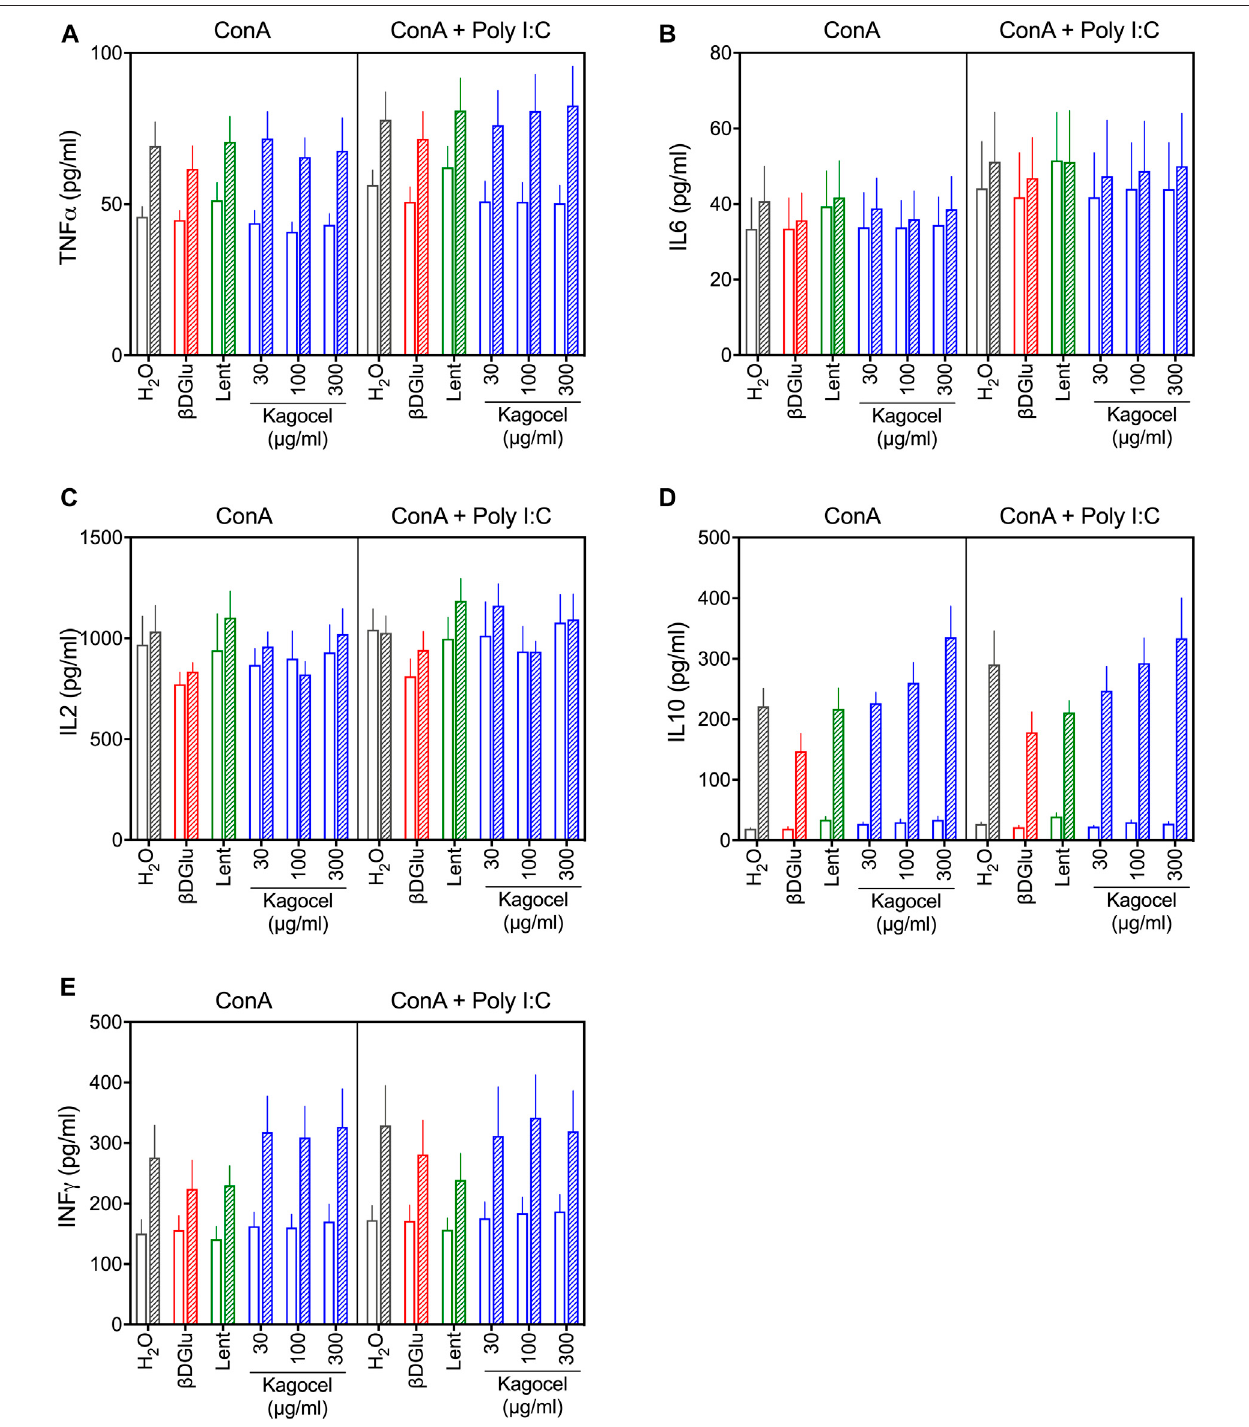
FIGURE 1 | TNF α (A) , IL6 (B) , IL2 (C) , IL10 (D) and INF γ (E) concentration in the media after 24 (open bars) and 72 h (hatched bars) of cultivation of Peyer ’ s patch lymphocytesstimulatedwithconcanavalinA(ConA,openbars)inabsenceorpresenceofTLR-3ligandpolyI:C.Cellsweretreatedwithsaline(H 2 O),300 μ g/mloats β -D Glucan ( β DGlu), 300 μ g/ml lentinan (Lent) or 30-300 μ g/ml kagocel. Results present mean ± s.e.m from 6 independent runs of the experiment. For statistics on drug effects see